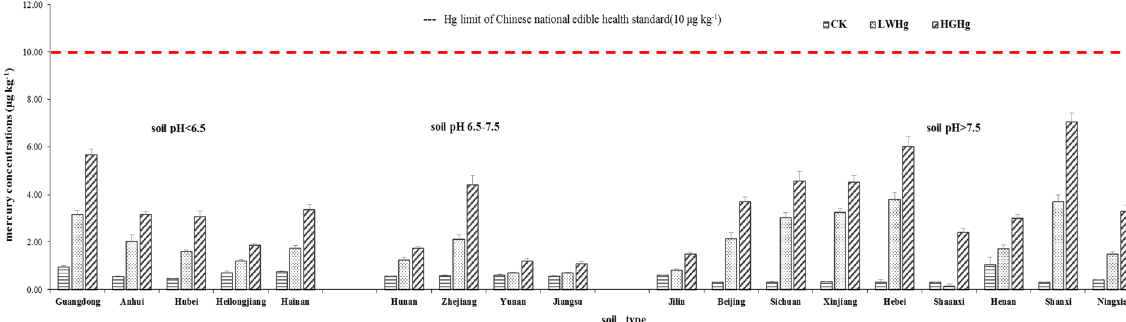
Figure 1. Hg content in the edible part of potato cultivars in 18 soils.